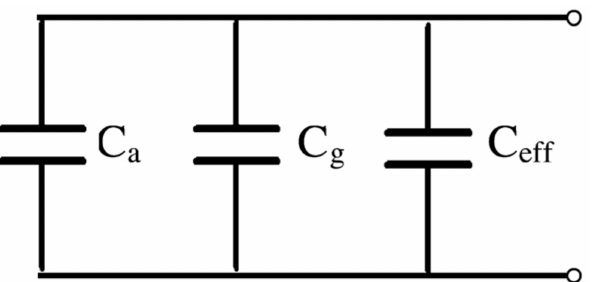
Figure 7. Schematic diagram of an electrical equivalent circuit model of the CP6 -based